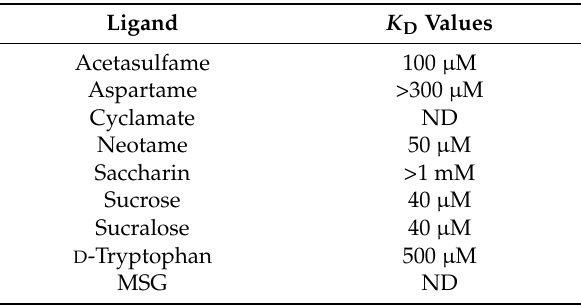
Table 1. Measured K D values by CD for the human T1R2